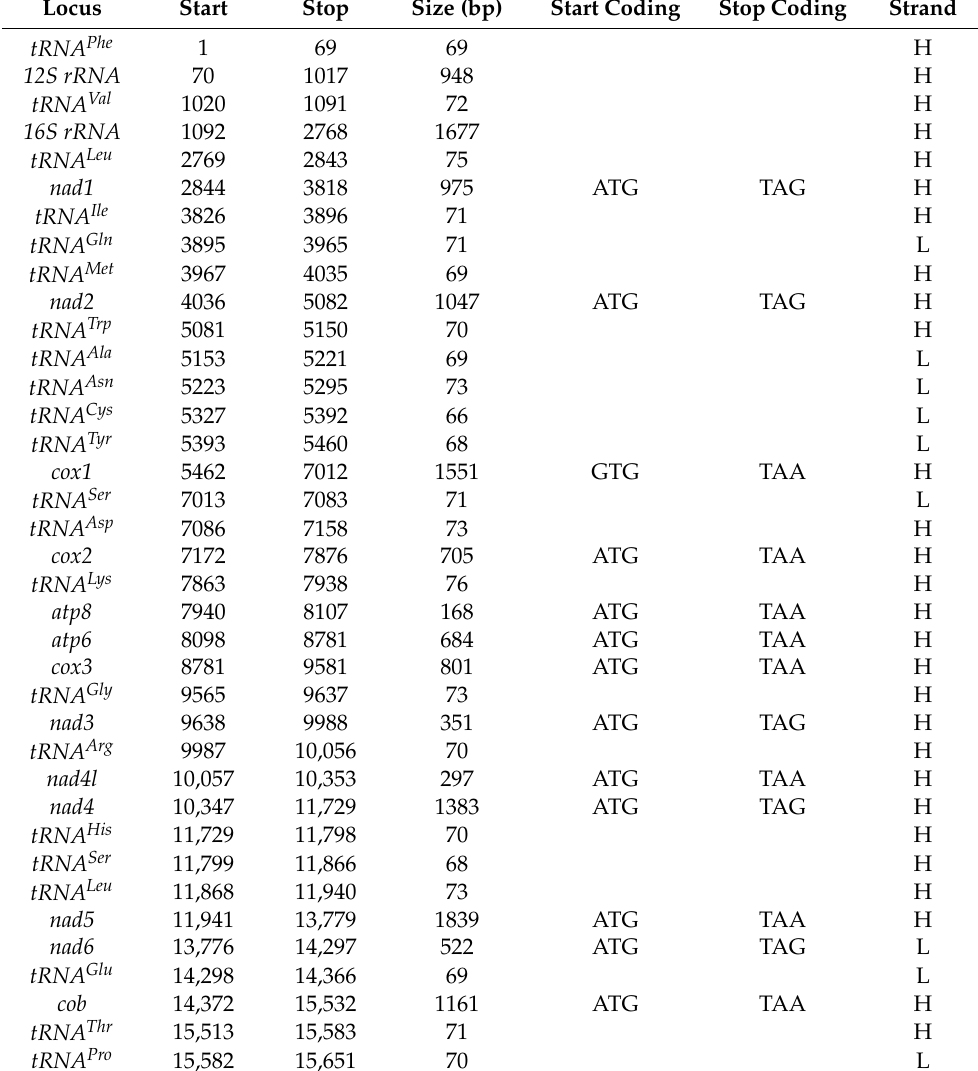
Table 2). The length of the 22 tRNAs ranged from 66 bp to 76 bp; tRNA Cys was the shortest (67 bp), whereas tRNA Lys was the longest (76 bp) in this study. The control region is 916 bp in length and is located between tRNA Pro and tRNA Phe . Table 2. Annotation of genes in the T. bombifrons mitogenome.